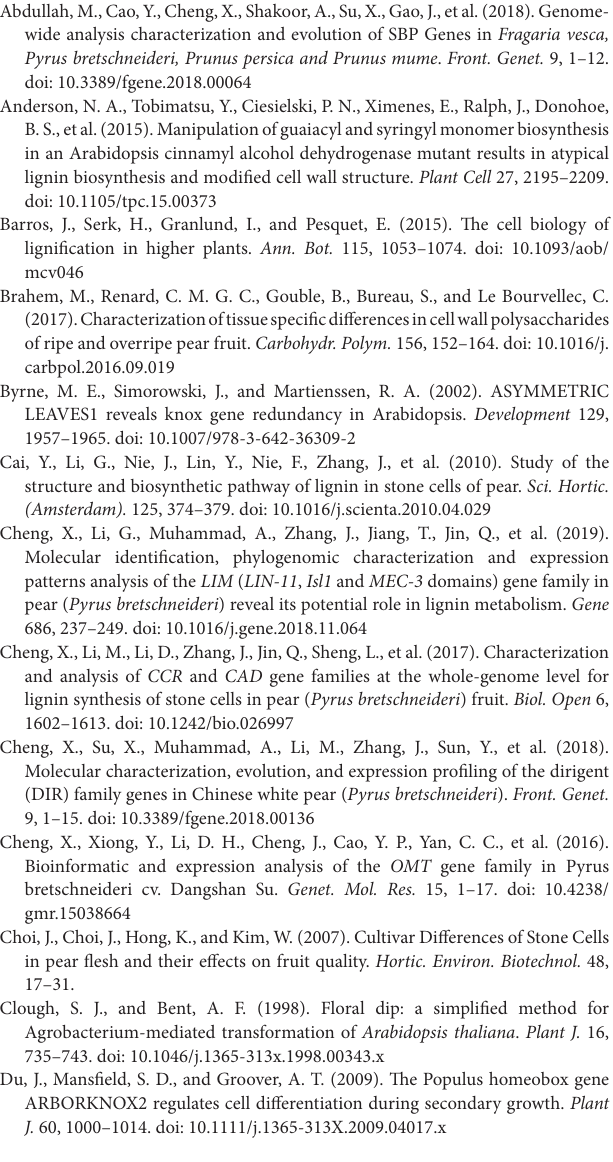
SUPPLEMENTARY TABLE 1 | GenBank accession codes used for constructing phylogenetic trees. SUPPLEMENTARY TABLE 2 | Primers for qRT-PCR and vector construction. SUPPLEMENTARY TABLE 3 | Details of 20 conserved motifs in the PbKNOXs.